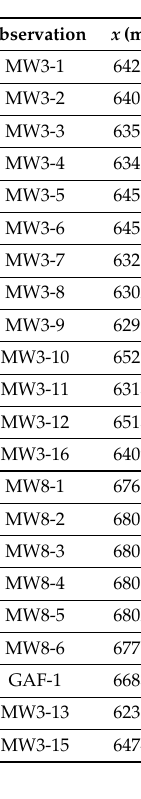
Table A1. Locations and average heads of